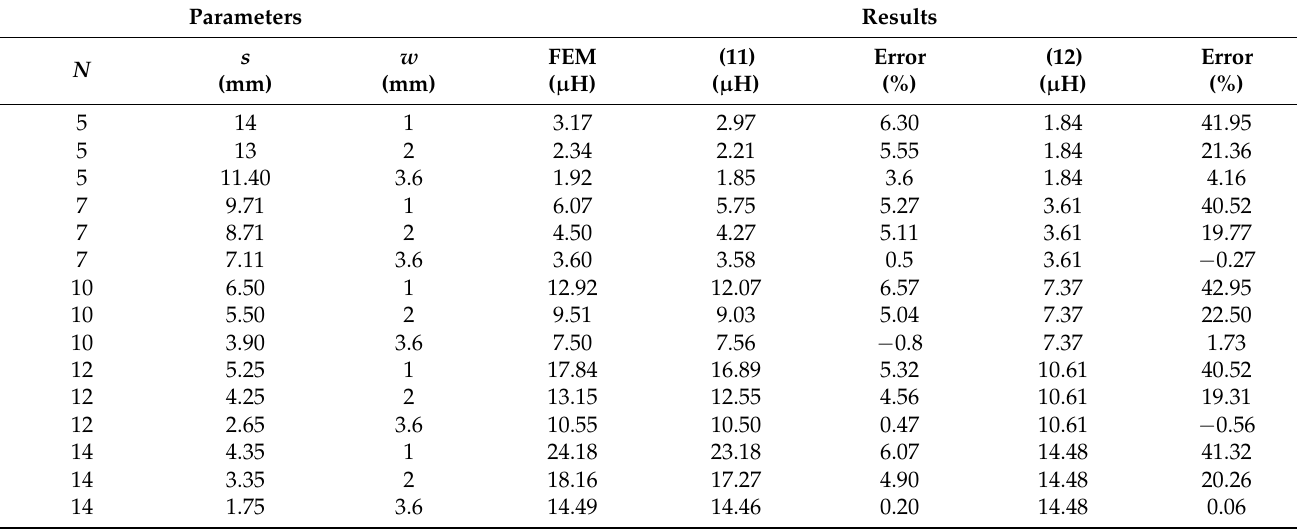
Table 2. Comparison Results with changing wire